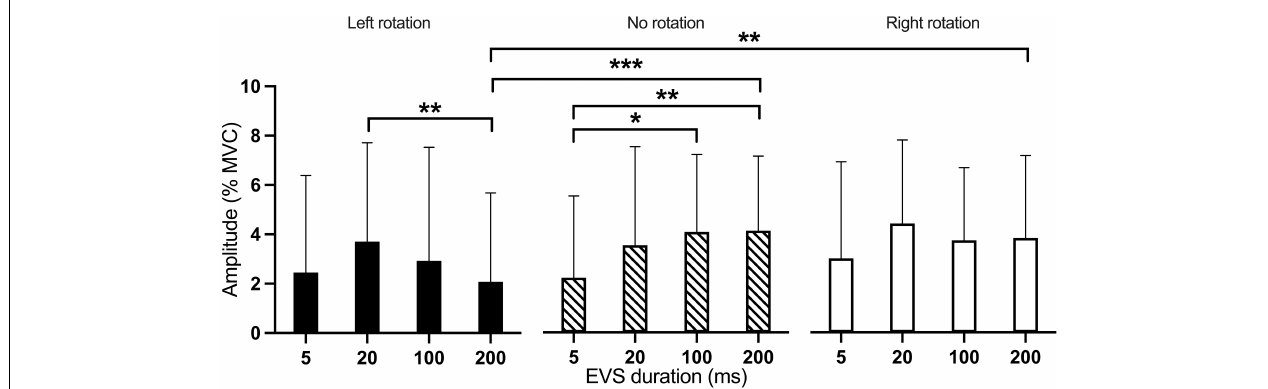
FIGURE 6 | Mean amplitude of the medium-latency response according to the interaction between EVS duration and head rotation. Results of the medium-latency response are represented as amplitude against EVS durations for the three head rotations. Black bar: left rotation; hatched bar: no rotation; White bar: right rotation. * p < 0.05; ** p < 0.01; *** p <